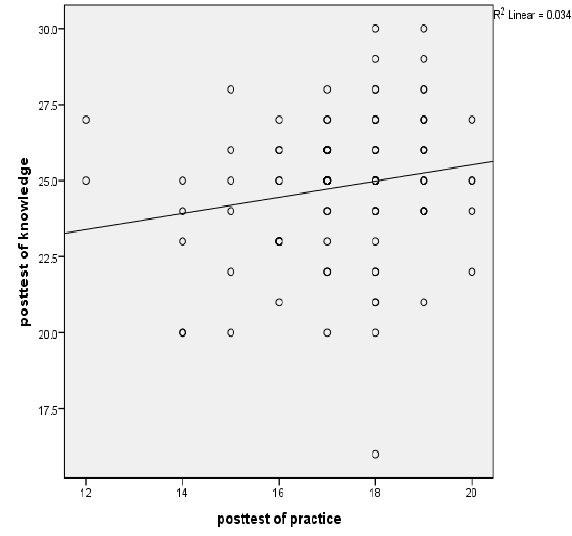
Figure 1: Correlation between knowledge and practice